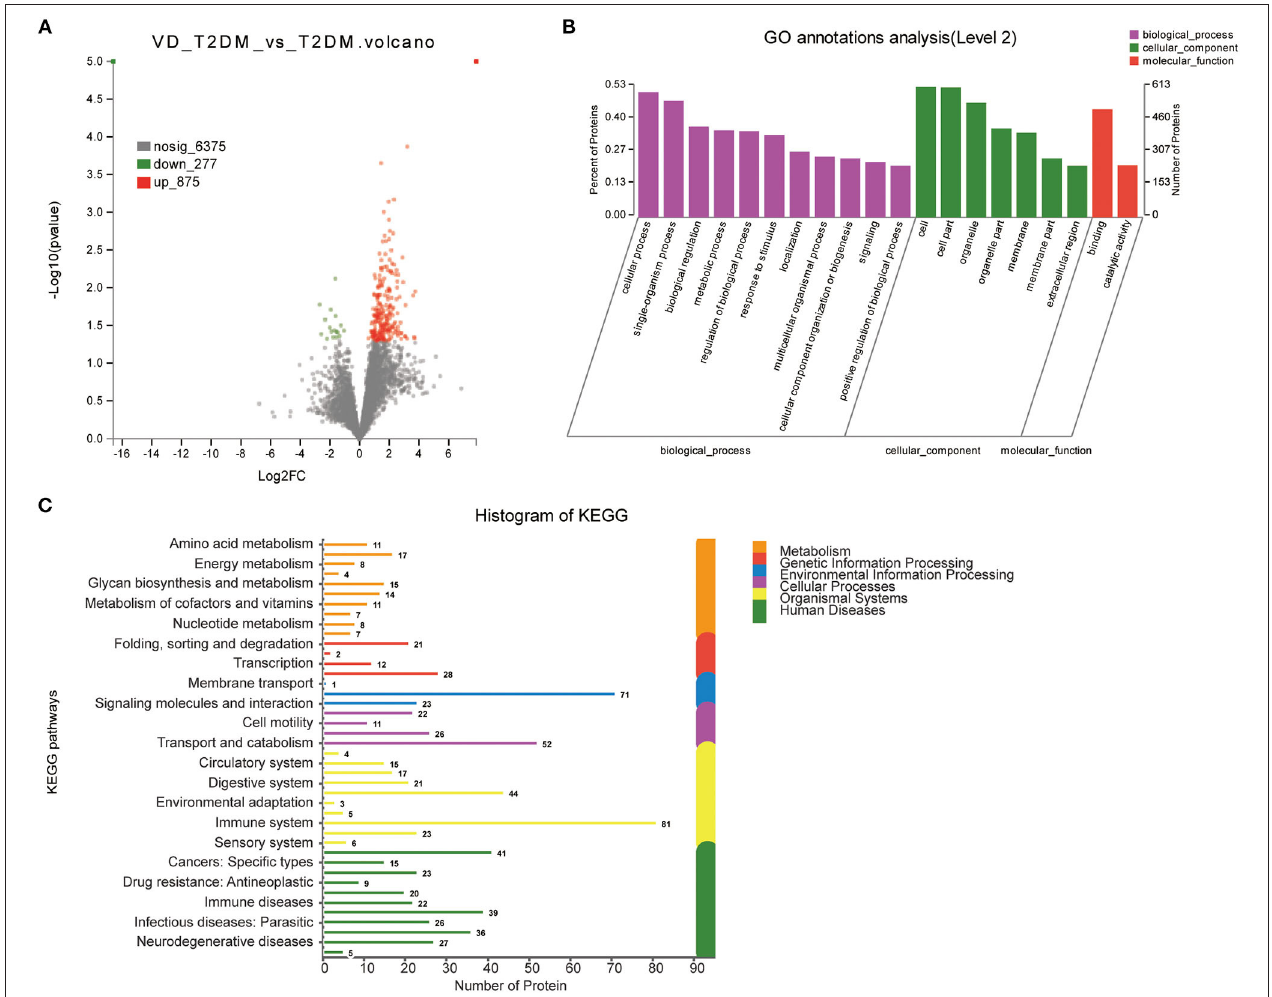
FIGURE 4 | Volcano plots of quantified proteins and functional analysis of DEPs in the urine between subjects with VD + T2DM and T2DM (notes same as Figures 1 – 3